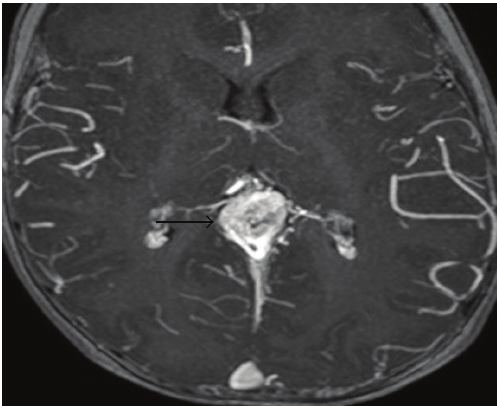
Figure 1: Colour duplex sonography: VGAM with mixed venous and arterial flow profiles.